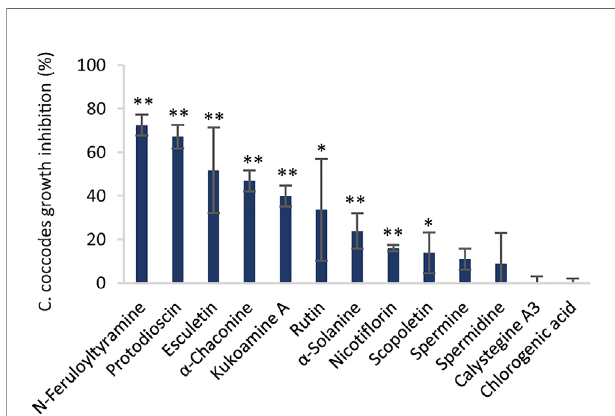
FIGURE 8 | Inhibition of C. coccodes growth (%) in vitro at 750 µM for chlorogenic acid and at 500 µM for the rest of the compounds (n=3, Mean ± Standard Deviation). Kukoamine A = N 1, N 12-bis(dihydrocaffeoyl) spermine. Asterisks indicate signi fi cant differences compared to the untreated control (*p < 0,05, **p < 0,01, Student ’ s T-test).